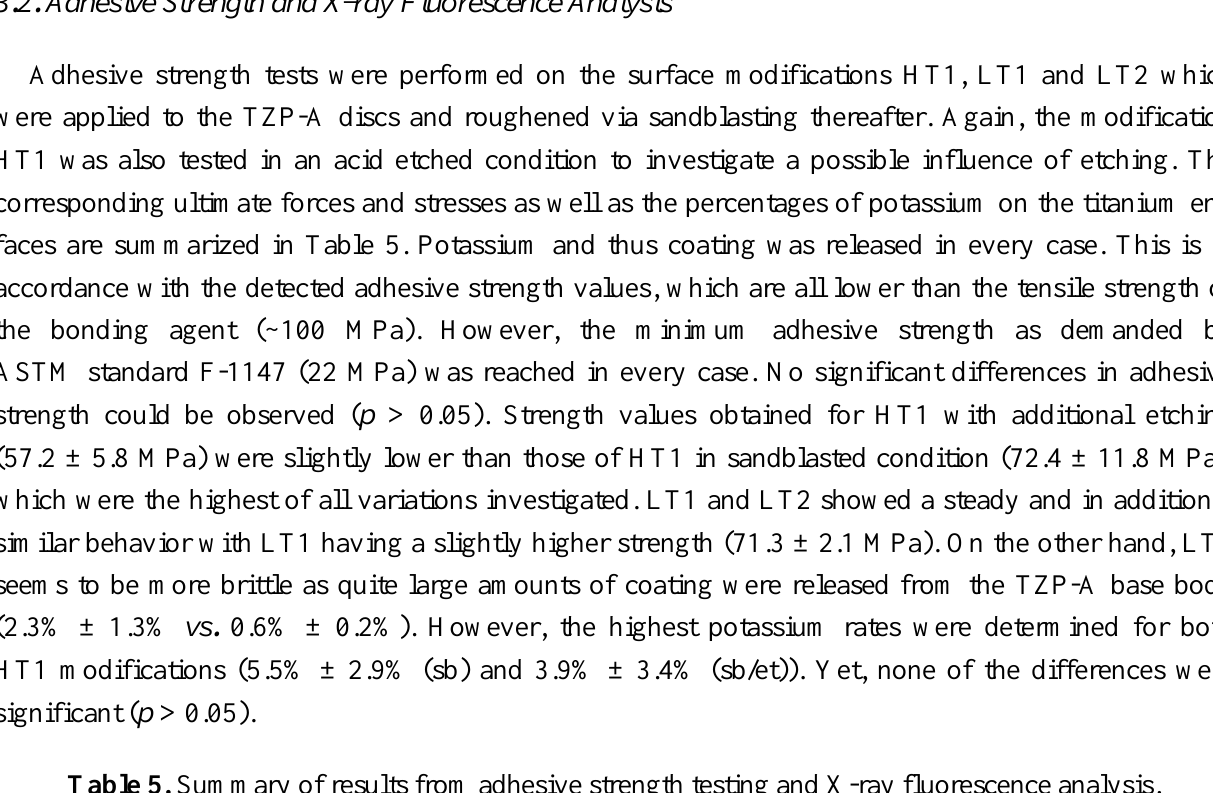
Table 5. Summary of results from adhesive strength testing and X-ray fluorescence analysis. Sample